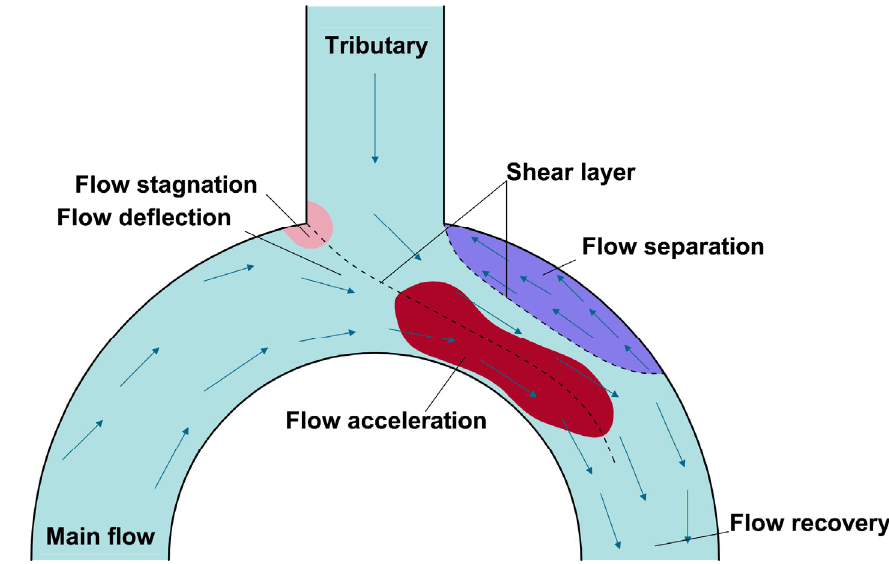
Figure 1. Various zones at the confluence of curved open ‐ channel with a tributary.